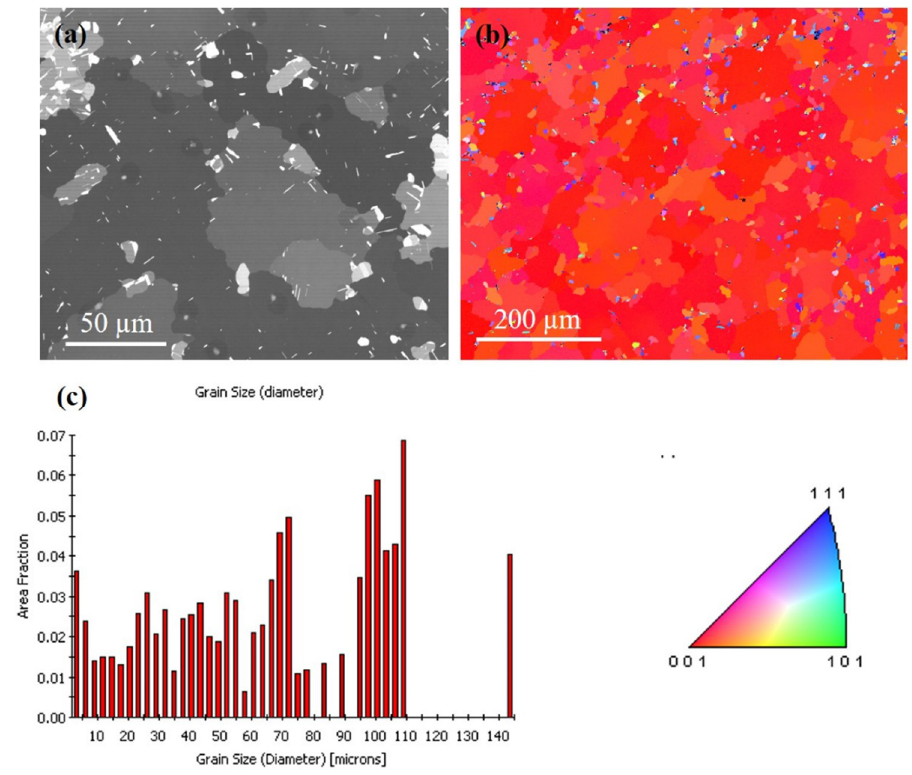
Figure 5. Grain morphologies for the Cu film at 250 °C for an hour. ( a ) FIB top-view image. ( b ) EBSD orientation image. ( c ) Grain size distribution of the grains in pole Figure 5b.